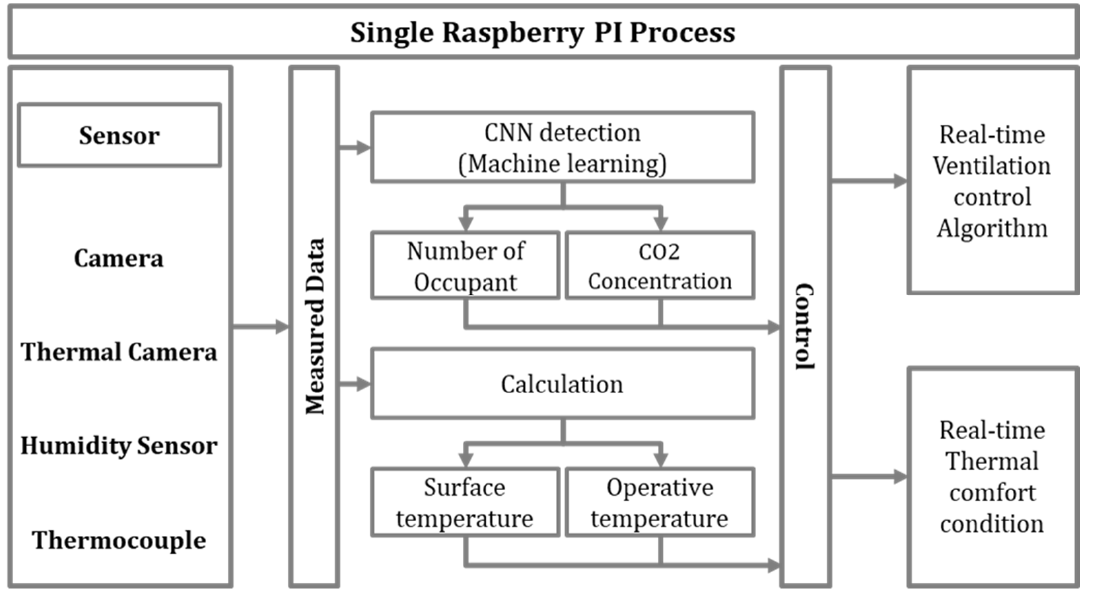
Figure 4. Full process in the IoT device.